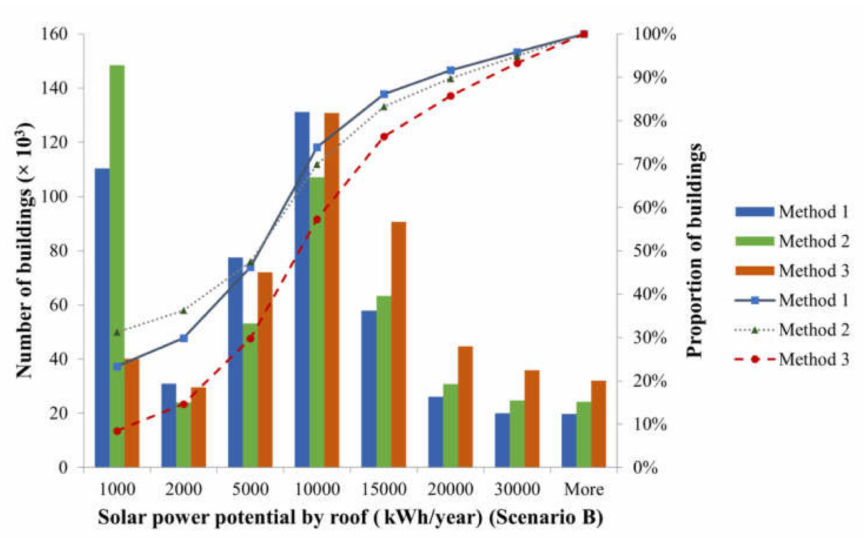
Figure 8. Number and cumulative proportion of buildings in relation to the solar power potential of each roof (kWh/year) in study area estimated by three methods under Scenario B. The electricity generation potential of solar PV estimated by the three methods in western Aichi under Scenario B is shown in Figure 9. The distribution pattern of solar power generation potential was similar for all the three methods. As for Method 2, since 26.7% of the total buildings in the study area were excluded due to the building height, the excluded buildings were mostly located in the southwestern and northern regions of the study area, which is the rural part of Nagoya City.